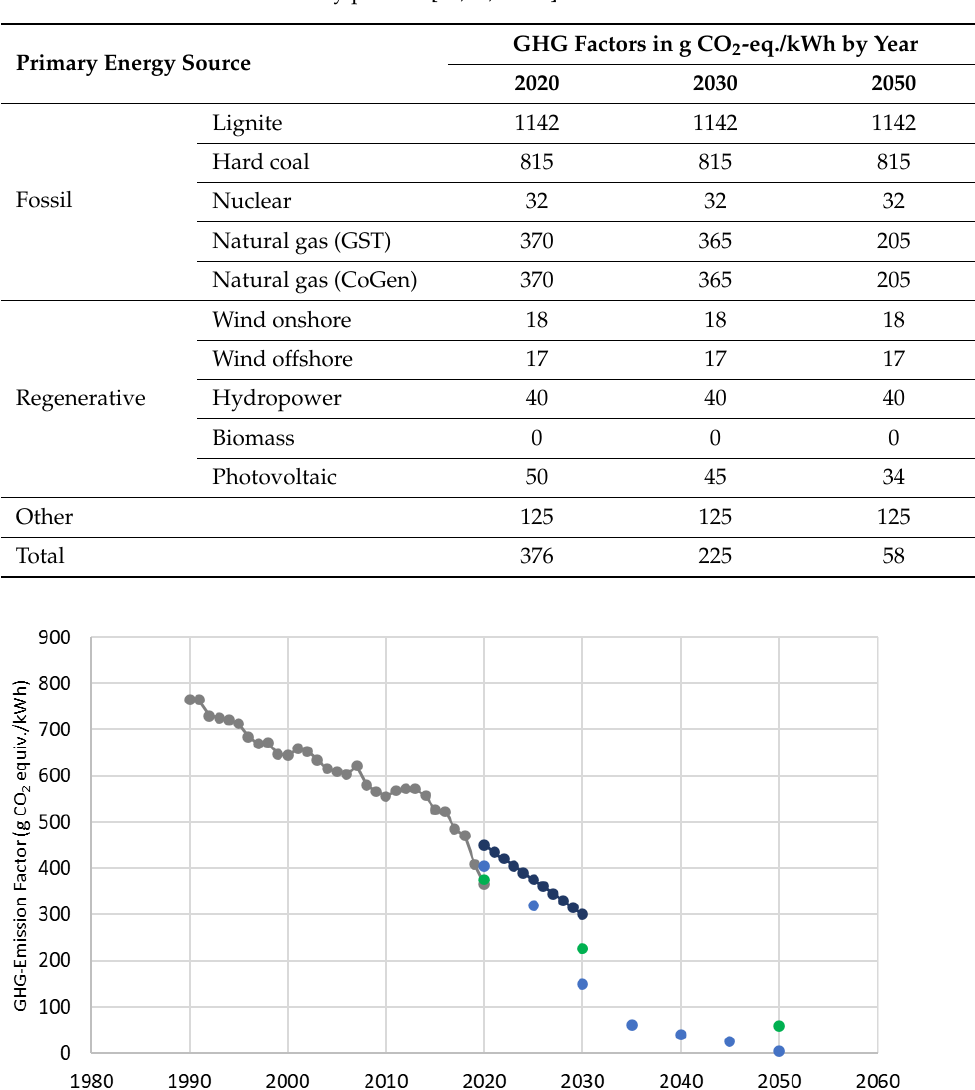
Table 10. GHG emission factors by process [20,31,62–66].